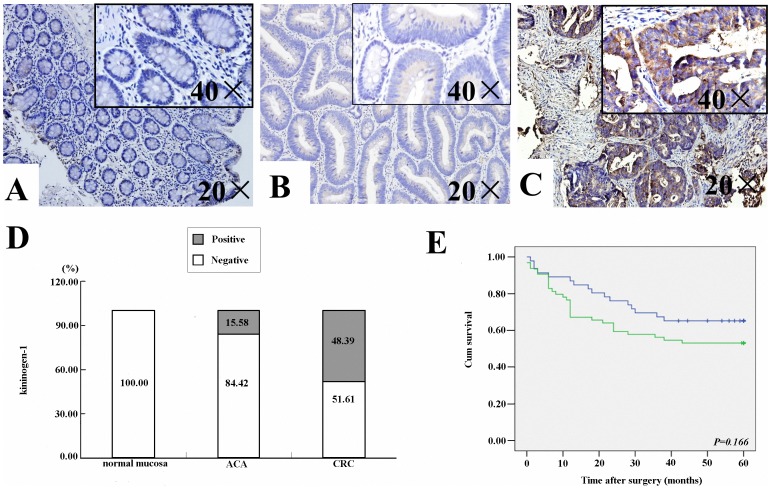
Expression of kininogen-1 in different colorectal tumor tissues and its relationship with survival.Representative immunostainings of kininogen-1 in normal colorectal mucosa (A), ACA tissue (B), and CRC tissue (C). Both overview (20×) and magnification (40×) images are provided, with the latter provided as inset boxes in the top left corner of each panel. D: Quantification of kininogen-1 levels in the control, ACA, and CRC groups. E: Survival curves for control, ACA, and CRC groups. The blue line represents CRC patients negative for kininogen-1 expression and the green line represents CRC patients positive for kininogen-1 expression.